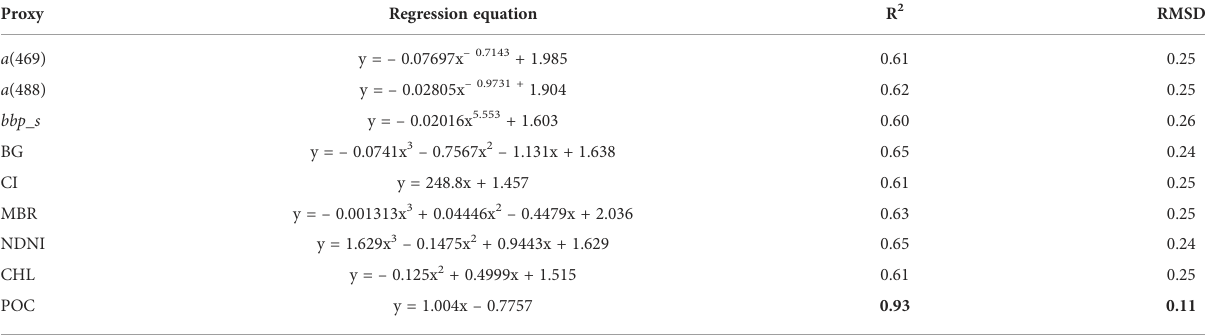
observed from the data points below the 1:1 line with PON >60 mg/m 3 . Similar to the model- fi tting results, the NDNI base produced the best validation performance with the highest R 2 (0.67) and slope for the regression line (0.69), and the lowest TABLE 3 The best- fi t regression models for the nine PON retrieval models and their statistical performance. Proxy Regression equation